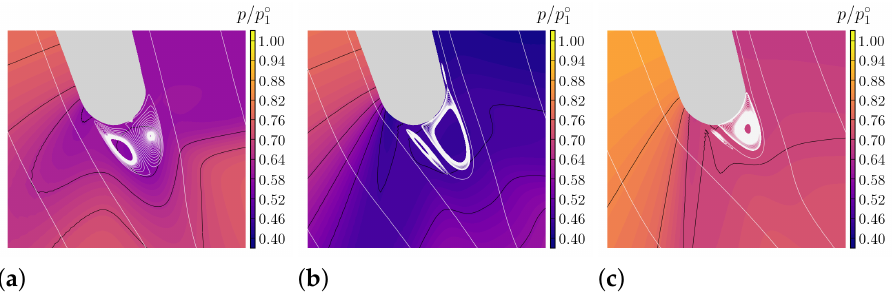
Figure 5. Close-up view of the trailing edge: isocontours of average pressure (background) and average stream lines for the cases IC1-LPR ( a ), IC1-HPR ( b ), and IC2-LPR ( c ). ) ) are The averaged distributions of the skin friction coefficient ( C f = τ w / ( 1/2 ρ 2 V 2 2 reported in Figure 6 as a function of the curvilinear coordinate S along the blade wall ( S = 0 at the leading edge, S < 0 at the pressure side, and S > 0 at the suction side), normalized with the chord C . The figure shows that, on average, the flow is fully attached for case IC1-LPR, except at the trailing edge (panel a). For case IC1-HPR, the interaction of the impinging right-running shock with the adjacent blade originates a small recirculation bubble for S / C 0.7. Afterwards, the flow reattaches to separate again at the trailing ≈ edge. Finally, for IC2-LPR, the complex interactions of the non-classical waves with the boundary layer at the blade suction side lead to successive separation and reattachment of the boundary layer, which is otherwise attached almost everywhere.